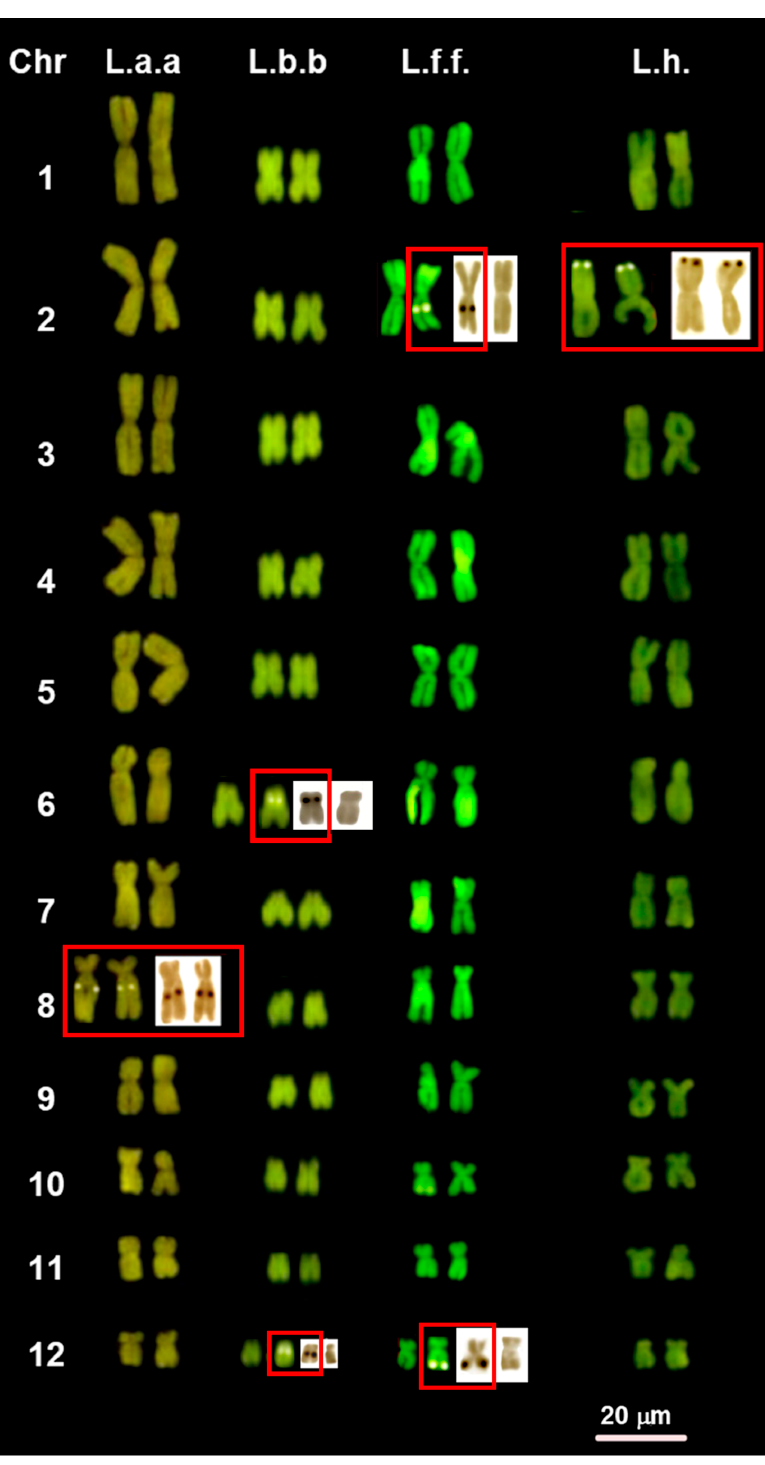
Figure 1. CMA 3 -stained karyotypes of: L.a.a. = L. a. antalyana; L.b.b. = L. b. billae ; L.f.f. = L. f. flavimembris ; L.h. = L. helverseni . NOR-bearing chromosomes stained with CMA 3 ( left ) and Ag-NOR staining ( right ). The red boxes highlight the occurrence of homomorphic and/or heteromorphic loci.